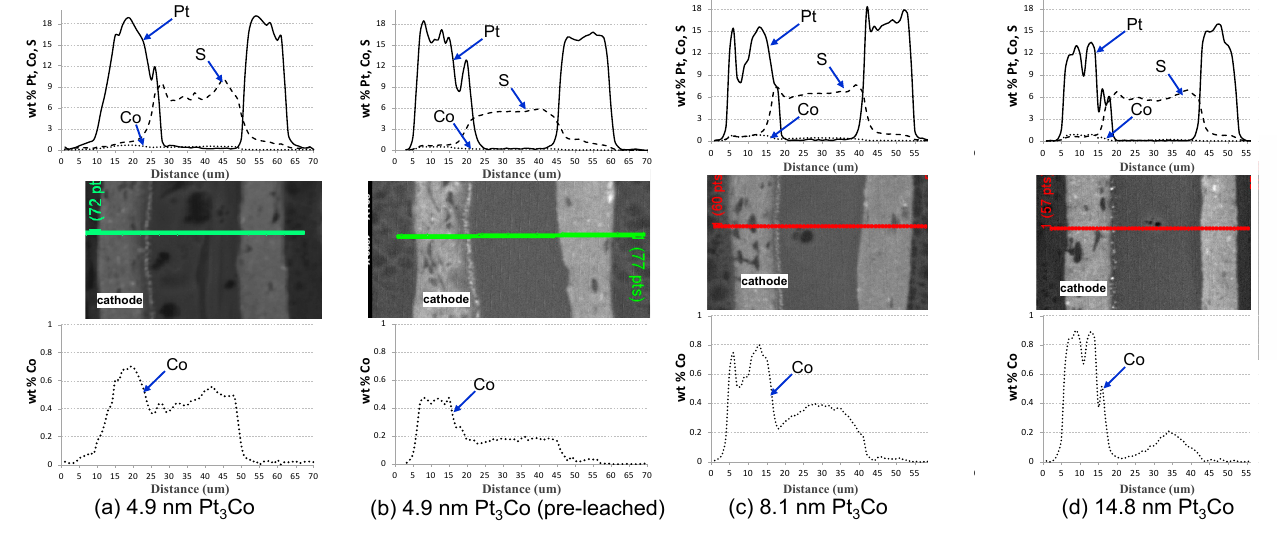
Figure 5. Post-test analysis of Pt 3 Co particle size study at subscale cell plan form midpoint shows minor migration of Pt and Co into membrane. Table 4. The loss of platinum calculated from EMPA, loss of cobalt calculated from the XRF, and post-cycling Pt to Co ratio in electrode from XRF after 30,000 cycles. % Co most from Mean diameter (nm) % of Pt lost into Cell # Pt/Co electrode (ECA, m 2 /g-Pt) membrane